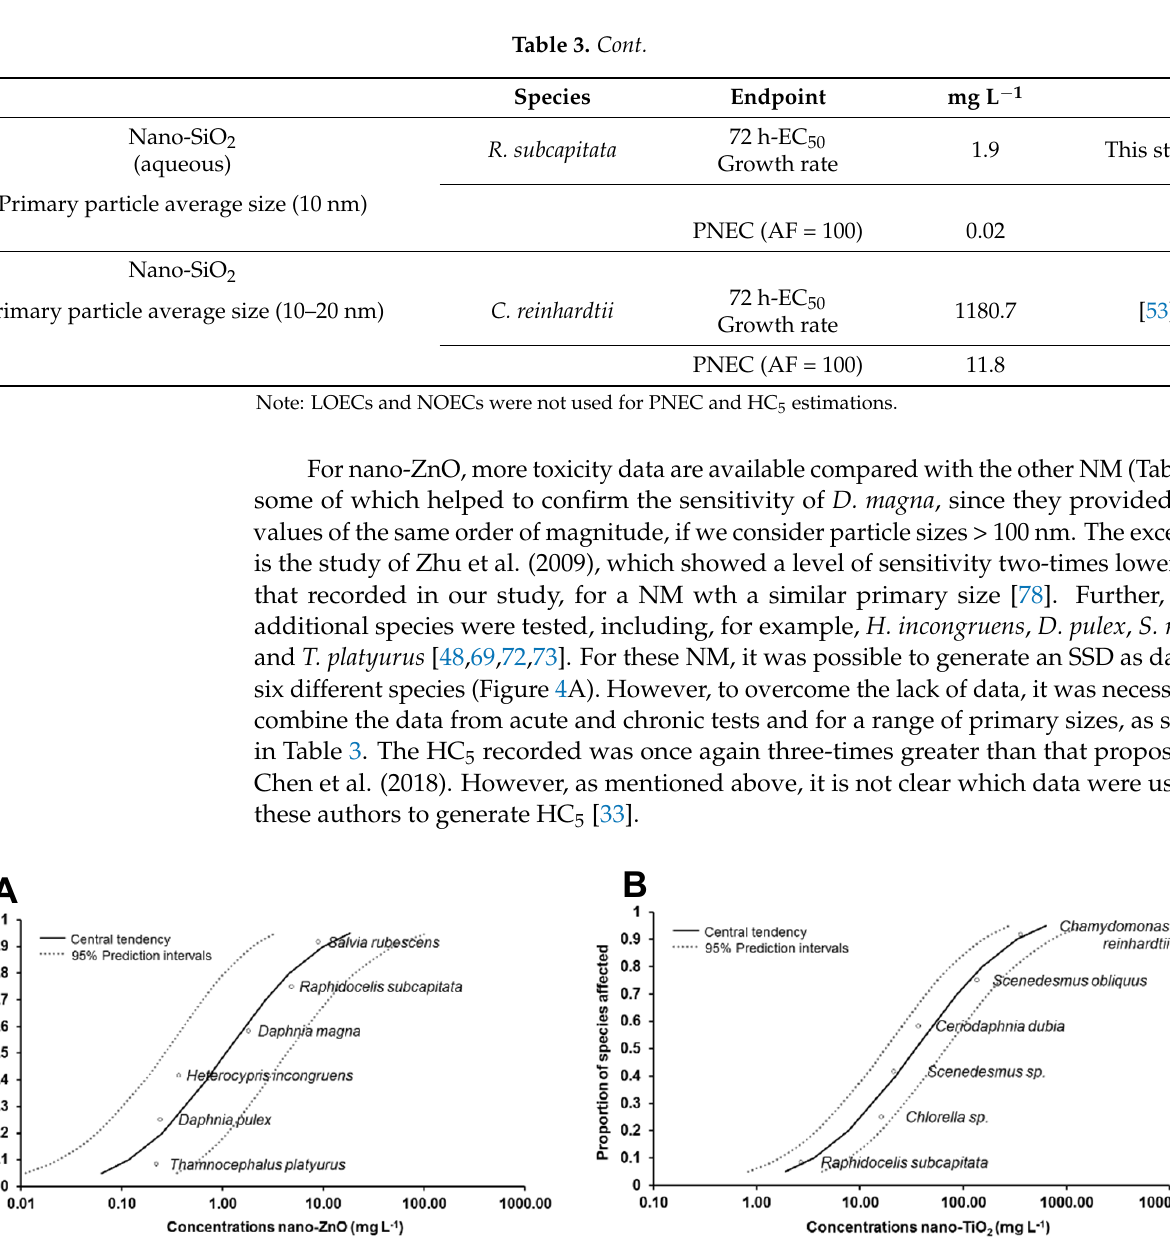
Figure 4. Species sensitivity distribution curves obtained by fitting toxicity endpoints to linearized log-normal model to toxicity endpoints available for nano-ZnO ( A ) and nano-TiO 2 ( B ).